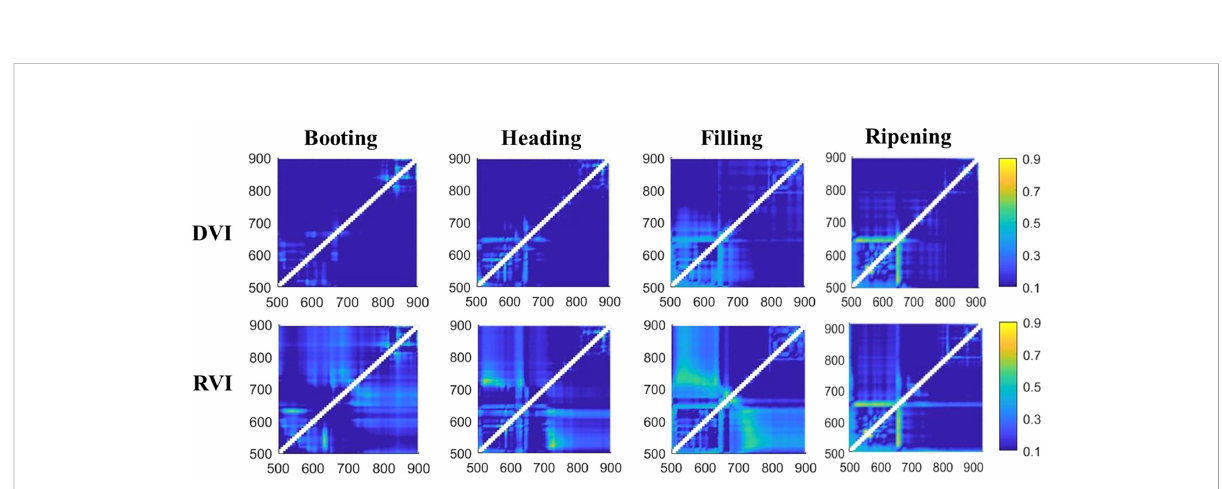
FIGURE 3 Matrix plots of correlation coef fi cients for the relationship between difference vegetation index (DVI) vs. amylose content (AC) and ratio vegetation index (RVI) vs. AC at different growth